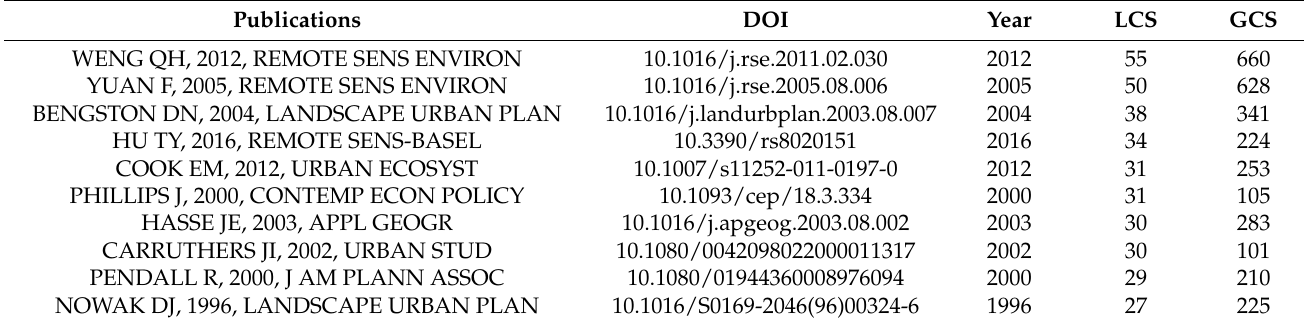
Table 4. Top 10 LCS publications in urban land management from 1979 to 2021.